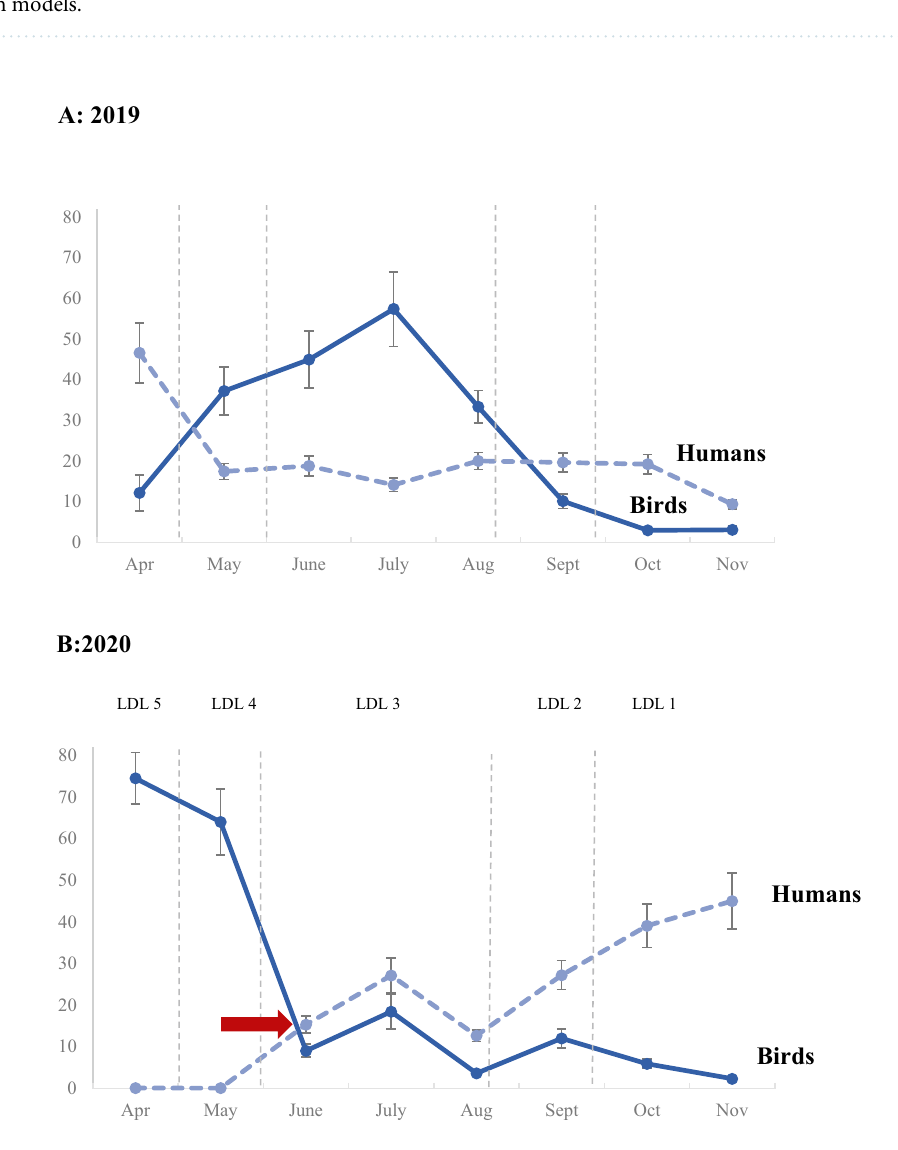
Figure 4. Mean (± 1 SE) shorebird and human abundance at Muizenberg Beach during ( A ) 2019 and ( B ) 2020. Trends are shown for the five lockdown levels (LDL 5 to 1, denoted by horizontal dashed lines) in 2020 and equivalent periods in 2019 (pre COVID-19). The red horizontal arrow in ( B ) shows the confluence of response curves for human and shorebird abundance, from which sensitivity of shorebird to human numbers was estimated during the transition from lockdown levels 5 and 4 to lockdown level 3 in